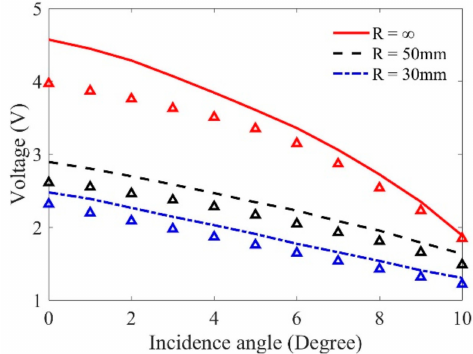
Figure 9. Comparison of wave magnitude results between predictions (lines) and measurements (triangles) using longitudinal waves when the curvatures and incidence angle